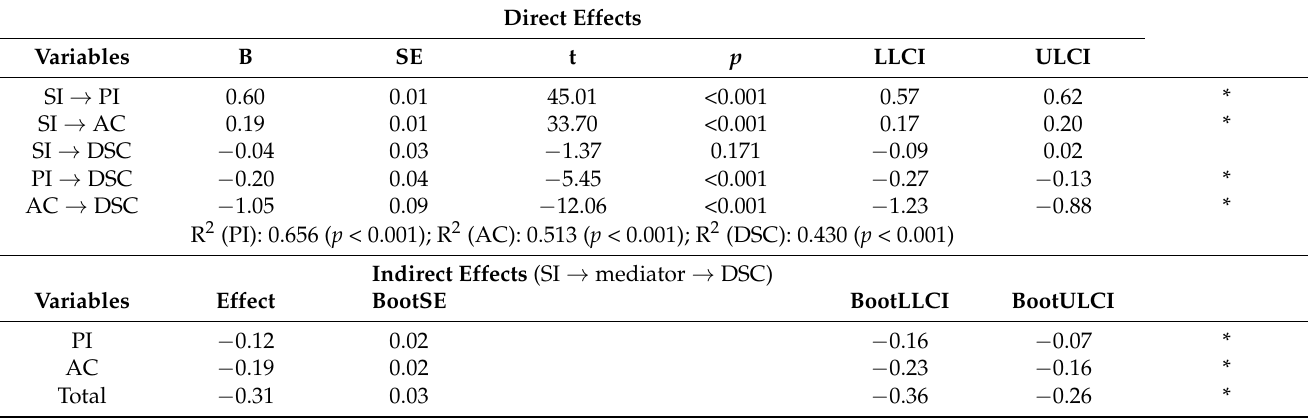
Table 3. Mediation